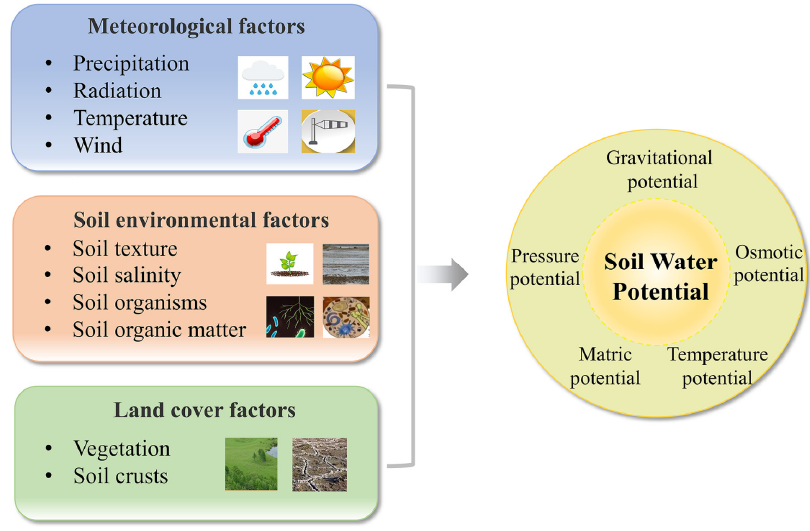
Figure 2. Schematic diagram of factors affecting soil water potential (SWP).